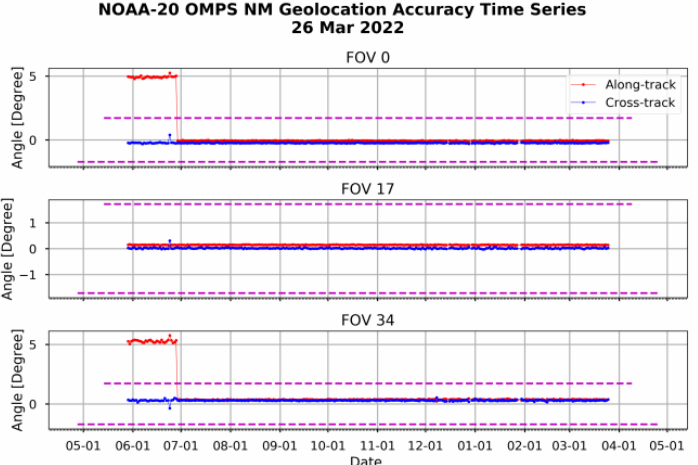
Figure 13. Time series of the assessment results for NOAA-20 OMPS-NM at macropixel FOV 0, 17 and 25, where different y -axis scales are used for three plots. The dashed lines indicate the ± 1/2 FOV size in terms of degree. The time series extended from 27 May 2021 to 26 March 2022 (309 days) and the data in each day contains 150–200 OMPS-NM lines with randomly selected non-uniform scenes.